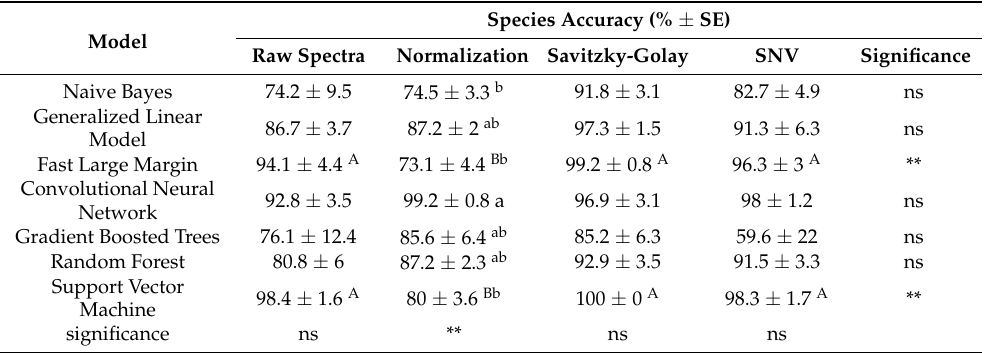
Table 2. Means of percentage of classification accuracy of different preprocessing and different clas- sification model using reflectance spectra.